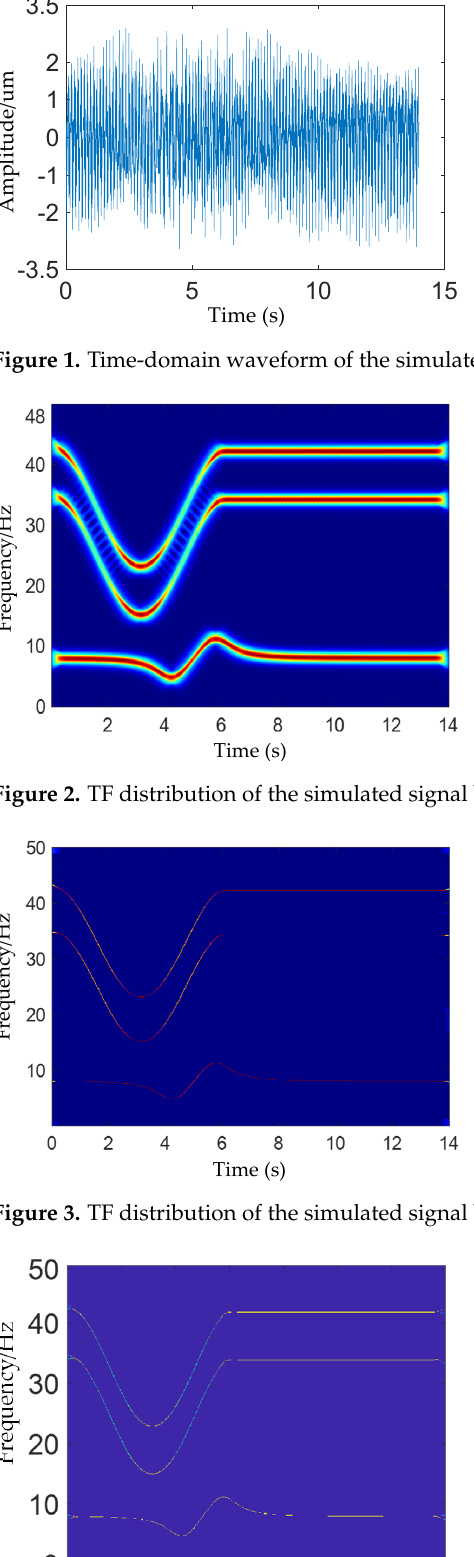
Figure 5. Time-domain waveform of the simulated signals with noise. Figure 6. TF distribution of the simulated signal with noise based on GLCT.